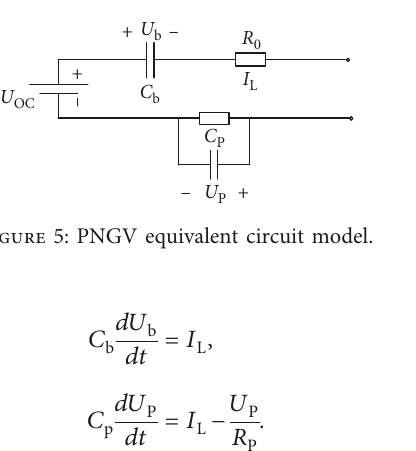
i 1 is closed, and (c) −